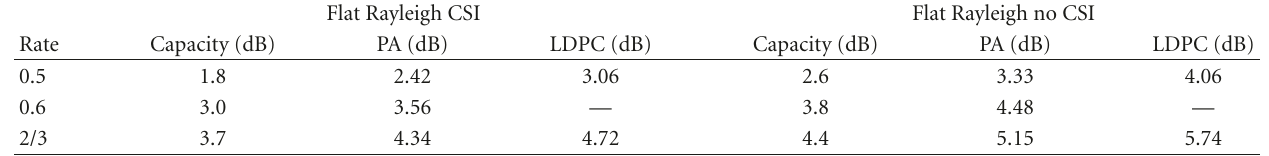
Table 1: Thresholds ( E b /N 0 in dB) of PA codes on Rayleigh channels ((3, ρ ) LDPC data by courtesy of Hou et al. [14]).